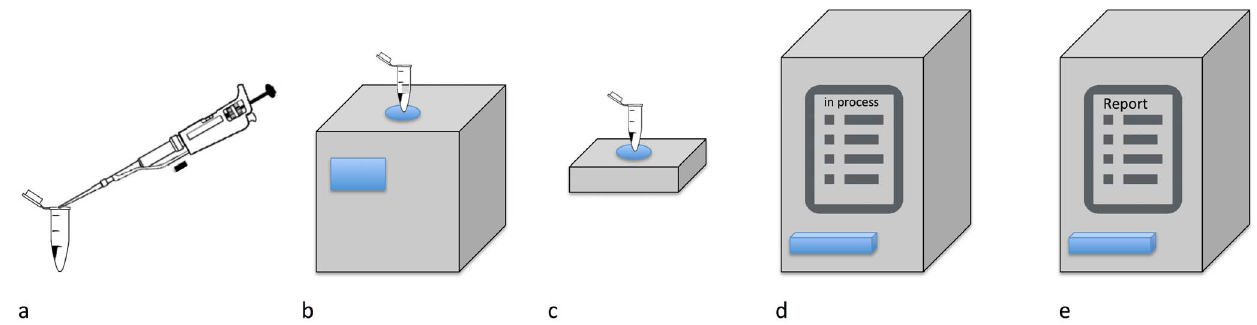
Figure 1. (a) Load sample tube, (b) insertion of sample tube into the Lysator, (c) transfer of sample tube and Master Mix into the Cartridge, (d) insertion of Cartridge into the Analyzer, (e) display of results.